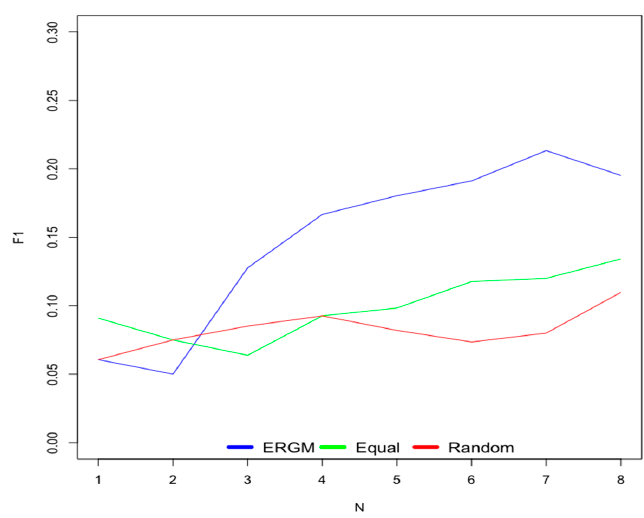
Figure 7. F 1 for old users. Figure 7. 𝐹 (cid:2869) for old users. Figure 7. 𝐹 (cid:2869) for old users.